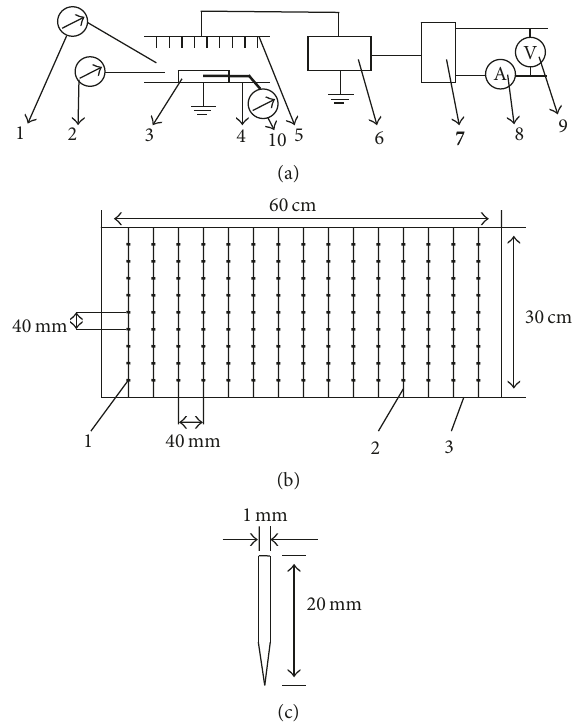
Figure 1: (a) Schematic diagram of HVAEF thawing: 1: thermome- ter; 2: hygrometer; 3: frozen tofu; 4: grounded plate electrode; 5: needle electrodes; 6: high-voltage power source; 7: voltage regulator; 8: ampere meter; 9: voltmeter; 10: temperature sensor. (b) Arrange- ment diagram of needle electrodes: 1: needle electrodes; 2: stainless steel wire; 3: stainless steel frame. (c) Schematic diagram of needle